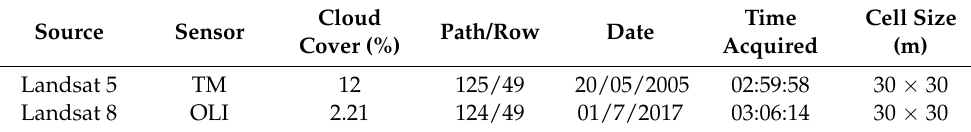
Table 2. Landsat image data for spatial analysis of temperature distribution. Time Cell Size Cloud Path/Row Date Source Sensor Acquired (m) Cover (%) Landsat 5 TM 12 125/49 20/05/2005 02:59:58 30 × 30 Landsat 8 OLI 2.21 124/49 01/7/2017 03:06:14 30 ×